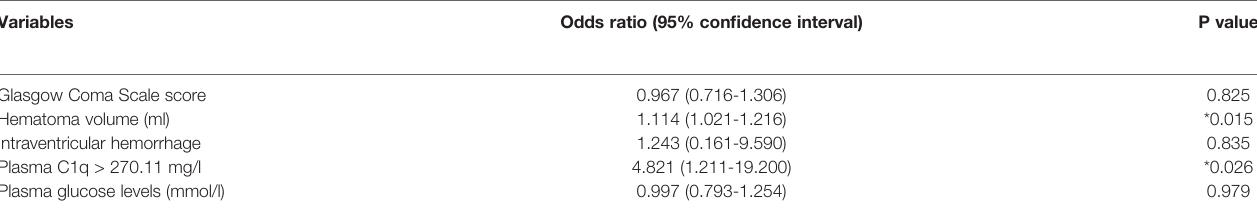
TABLE 5 | Multivariate logistic regression analysis for risk factors of poor 3-month prognosis in acute intracerebral hemorrhage. Variables Odds ratio (95% con fi dence interval) P value